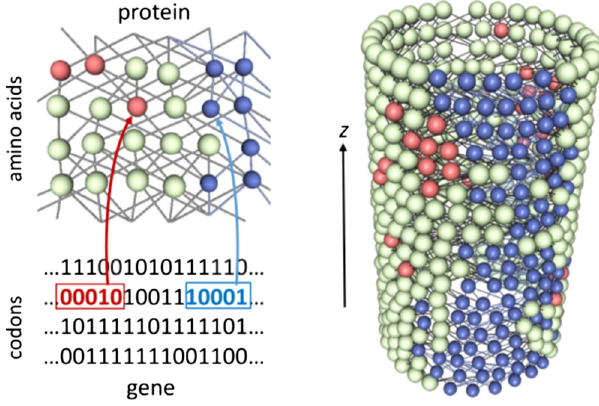
FIG. 1. The main features of the physical model. Left: The mapping from the binary gene to the connectivity of the amino acid (AA) network that makes a functional protein. AAs are beads and links are bonds. The color of the AAs represents their rigidity state as determined by the connectivity according to the algorithm of Appendix A 3. Each AA can be in one of three states: rigid (gray) or fluid (i.e., nonrigid), which are divided between shearable (blue) and nonshearable (red). Right: The AAs in the model protein are arranged in the shape of a cylinder, in this case with a fluid channel (blue region). Such a configuration can transduce a mechanical signal of shear or hinge motion along the fluid